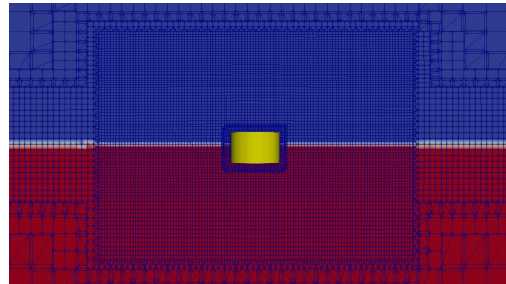
Fig. 5. The mesh is refined in the vicinity of the buoy. There is an outer refinement box surrounding the buoy and even finer region closer to the buoy, which contains the boundary layer. For adequately capturing the wave propagation, the refined region is applied in the water surface.